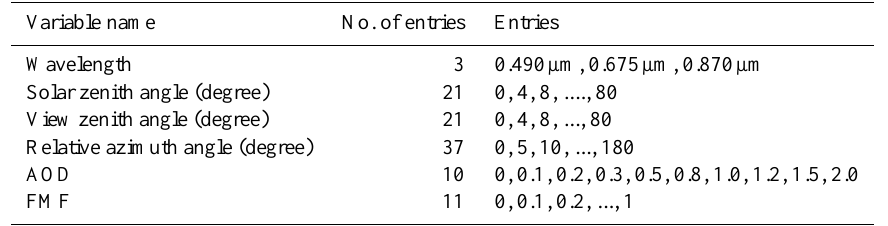
Table 1. Dimensions of LUTs for aerosol